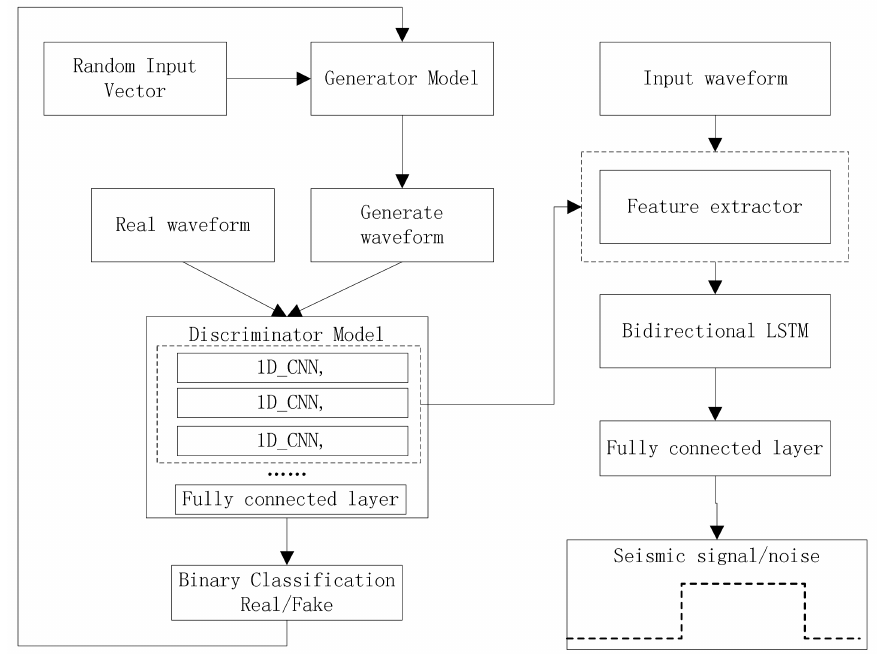
Figure 6. Architecture of the GAN-LSTM joint network (Generative adversarial network, GAN; Long short-term memory network, LSTM). First, real seismic signals are used to train the GAN. After training, the discriminator of GAN is regarded as feature extractors, and the convolutional layers of the discriminator are connected to the LSTM to build the classification network for seismic and noise